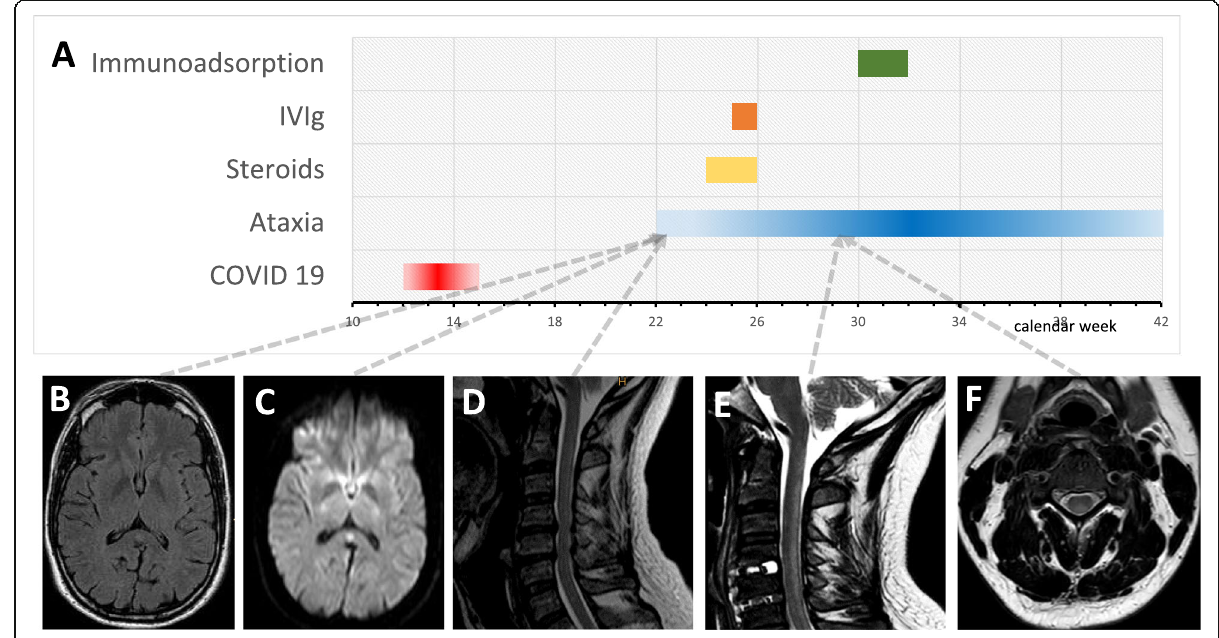
Fig. 1 a Disease course and treatment of the patient. b Axial fluid-attenuated inversion recovery (FLAIR) and c axial diffusion-weighted imaging (DWI) show a hyperintensity in the splenium of the corpus callosum. d Sagittal T2 sequence of the cervical spine shows disc protrusion with spinal canal stenosis at C4-C6. e Postoperative sagittal and f axial T2 images of the cervical spine show a new hyperintensity in the dorsal columns extending from the cranial base to